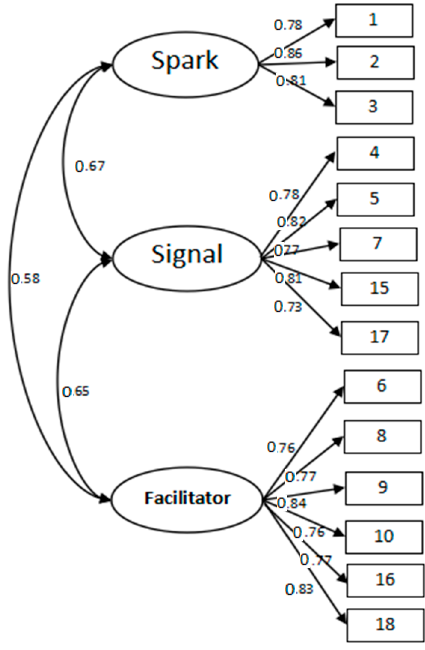
Figure 1. Confirmatory Factor Analysis of the 14 items.